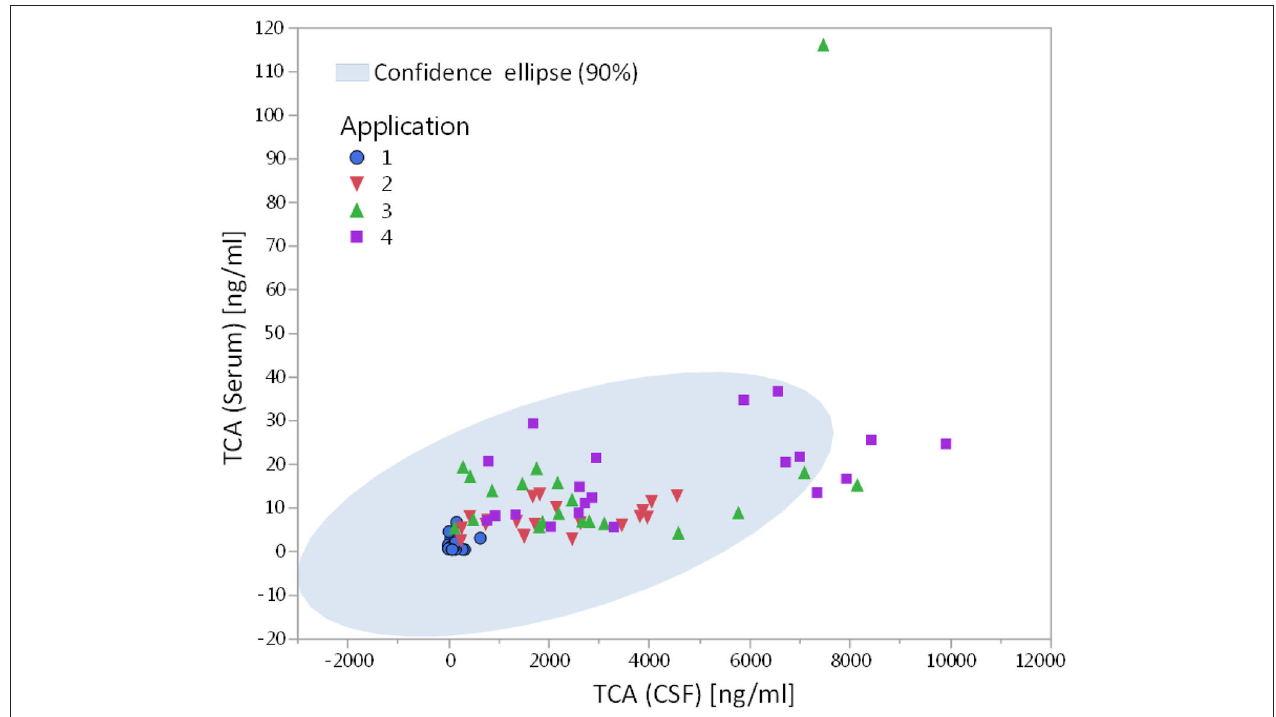
TABLE 2 | Significance values for steroid concentrations in CSF and serum during TCA treatment of MS patients. CSF Serum Steroid hormone Application Gender Interaction Application Gender Interaction